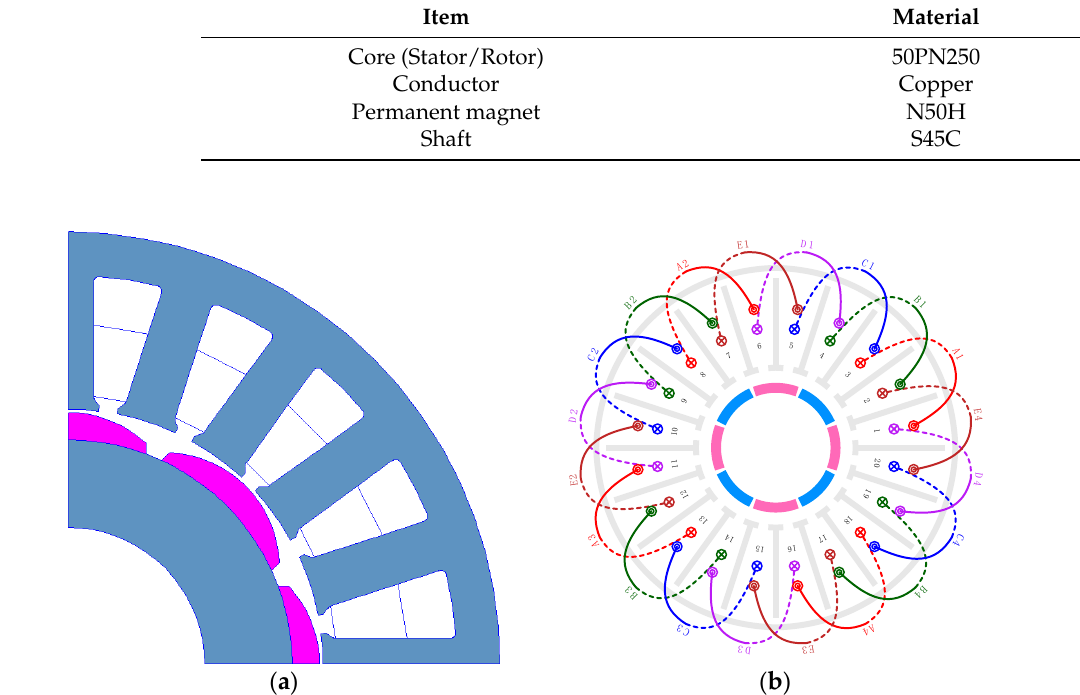
Figure 2. Design representation of the five-phase PMSM: ( a ) cross-section, ( b ) winding configuration. Table 1. Design parameters of the five-phase PMSM.